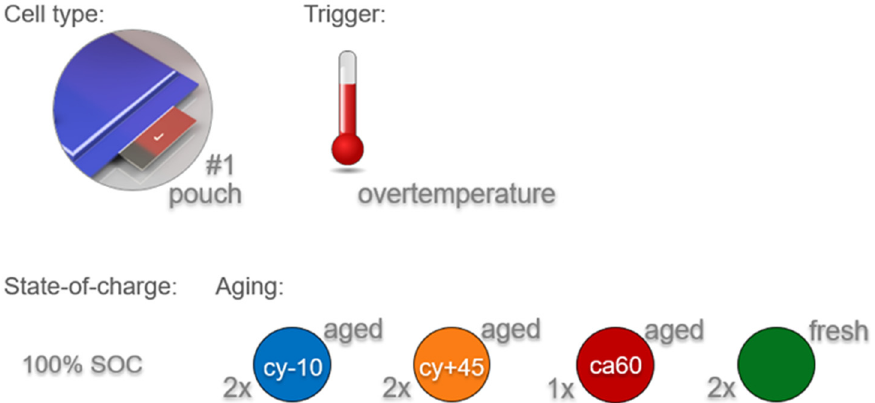
Figure 2. Design of experiment to investigate the influence of aging on the failing behavior: In total, five aged and two fresh #1 pouch cells were triggered into thermal runaway (TR) using overtemperature TR trigger.